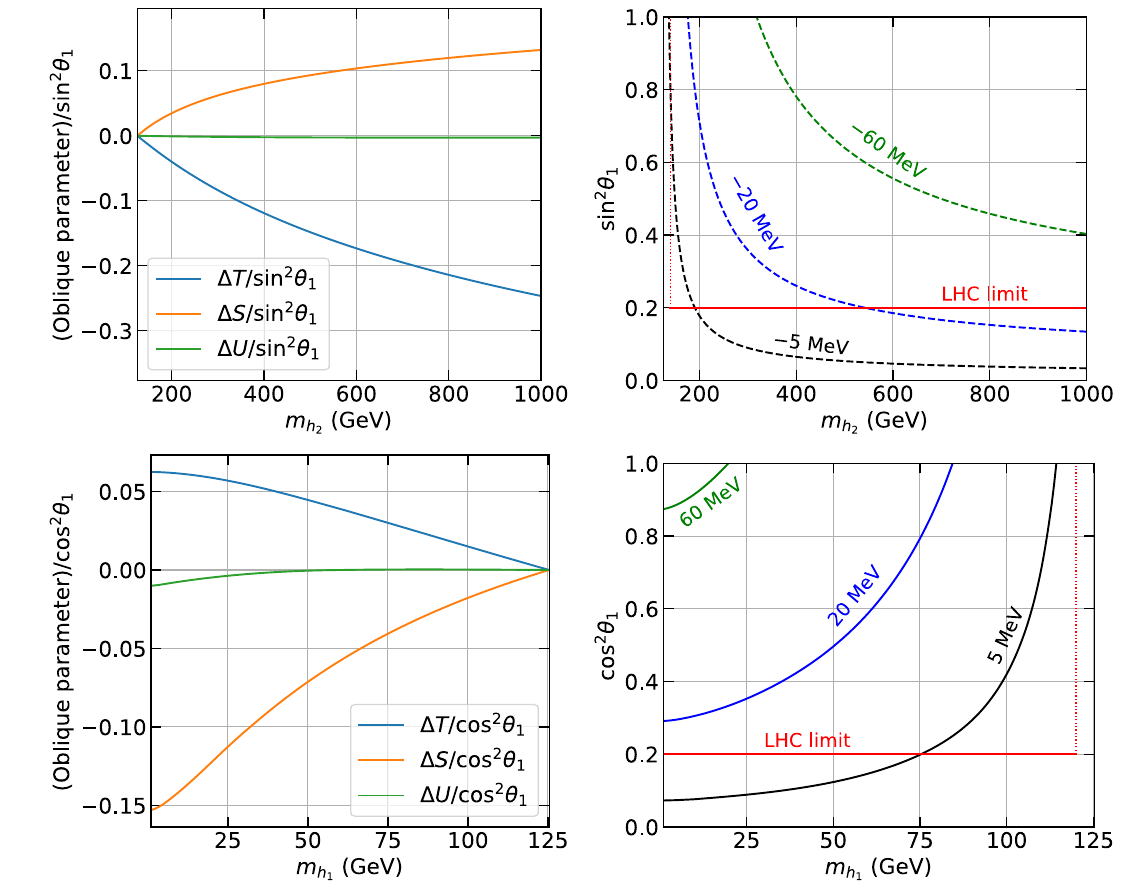
Fig. 4 Upper panels: the oblique parameters divided by sin 2 θ 1 as a function of m h (left) and contours for the W boson mass shift, (cid:5) m W , 2 projected on the ( m h , sin 2 θ 1 ) plane (right) for the case where h 1 is 2 identified to be the observed Higgs boson. Lower panels: likewise but ↔ m sin 2 θ 1 → cos 2 θ 1 and m h h 1 , for the case where h 2 is identified 2 to be the observed Higgs boson. The dashed black, blue and green (solid black, blue and green) lines on the upper (lower) right panel represent